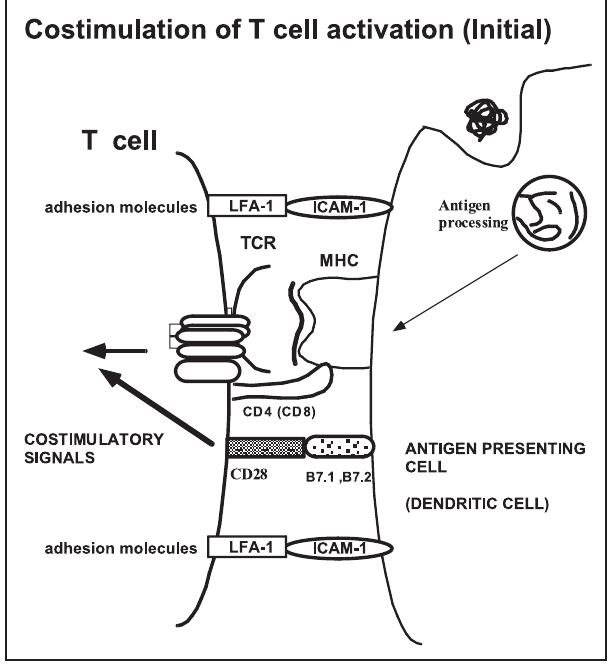
senting cells degrade pathogens. Peptides from the pathogen are brought to the cell surface as a complex with a major histocompatibility complex (MHC) protein. T cells, via their clonally distributed antigen specific receptors bind to MHC peptide complexes. The frequency of T cells specific for a specific MHC-peptide complex prior to immunization is estimated to be about one in 10 7 . The interaction between CD28 on the T cell and B7.1 or B7.2 on a mature dendritic cell provides a crit- ical costimulatory signal for T cell activation. The antigen presenting cell-T cell interaction is also stabilized by adhesion molecules. ICAM Intercellular adhesion molecule-1; LFA-1 Leukocyte function- associated antigen-1; TCR T cell